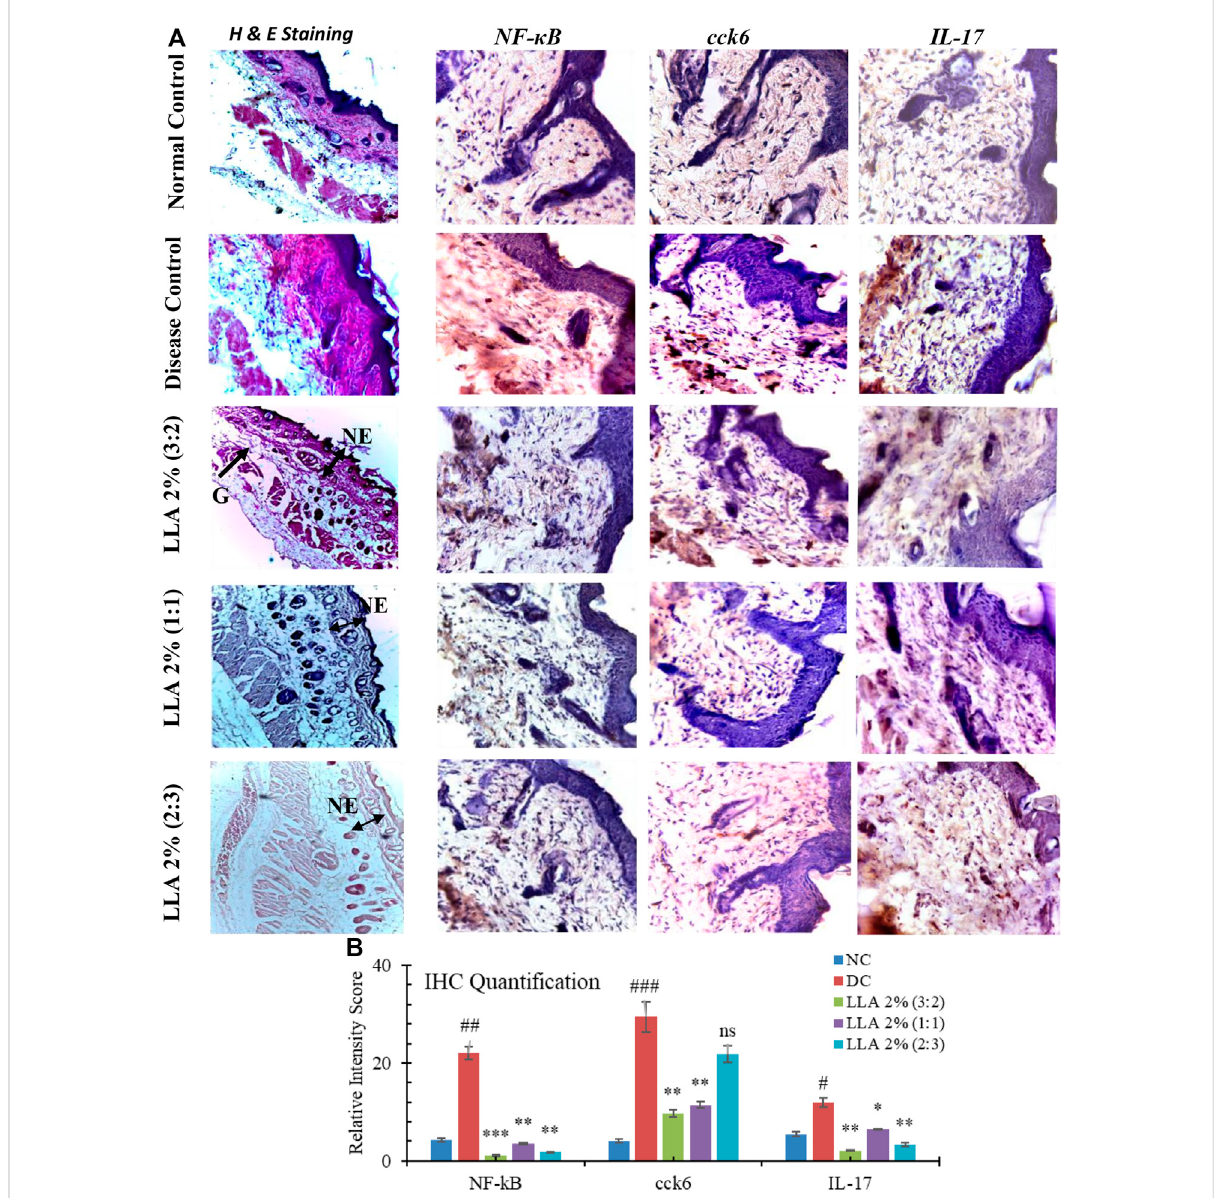
FIGURE 4 Histopathological features of the skin treated with linalool and linalyl acetate in combination. Immunohistochemical images of the mice skin treated with linalool + linalyl acetate combinations. (A) Histopathological features and immunohistochemical images of the mouse skin treated with linalool + linalyl acetate combinations. Sections were stained with H and E, and pictures were visualized at 10X magni fi cation. (B) depicts the individual protein ’ s relative intensity scores of the IHC expressions. LLA (2%); linalool + linalyl acetate in 3:2, 1:1, and 2:3 ratios at 2% concentration. NE; normal epidermis, G; granulosis. The brown color represents NF- κ B, IL-17, and cck6